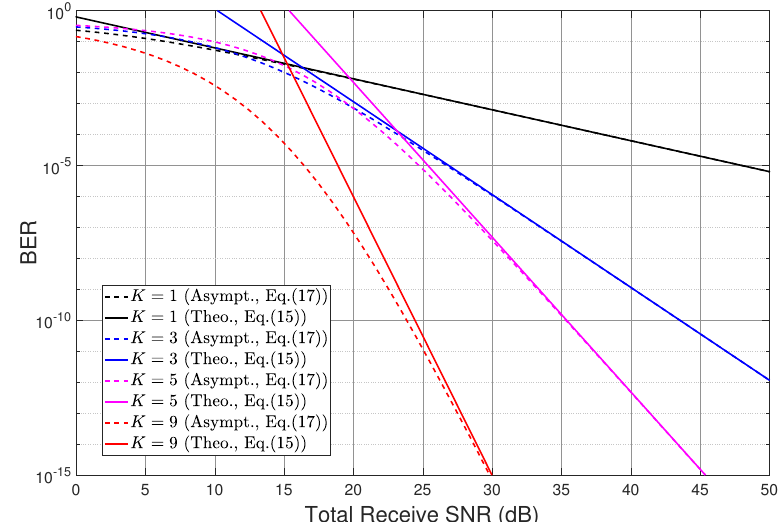
Figure 4. Diversity order of LPWAN according to the number of total received antennas when d 1 = 1, d 2 = 3, and d 3 =